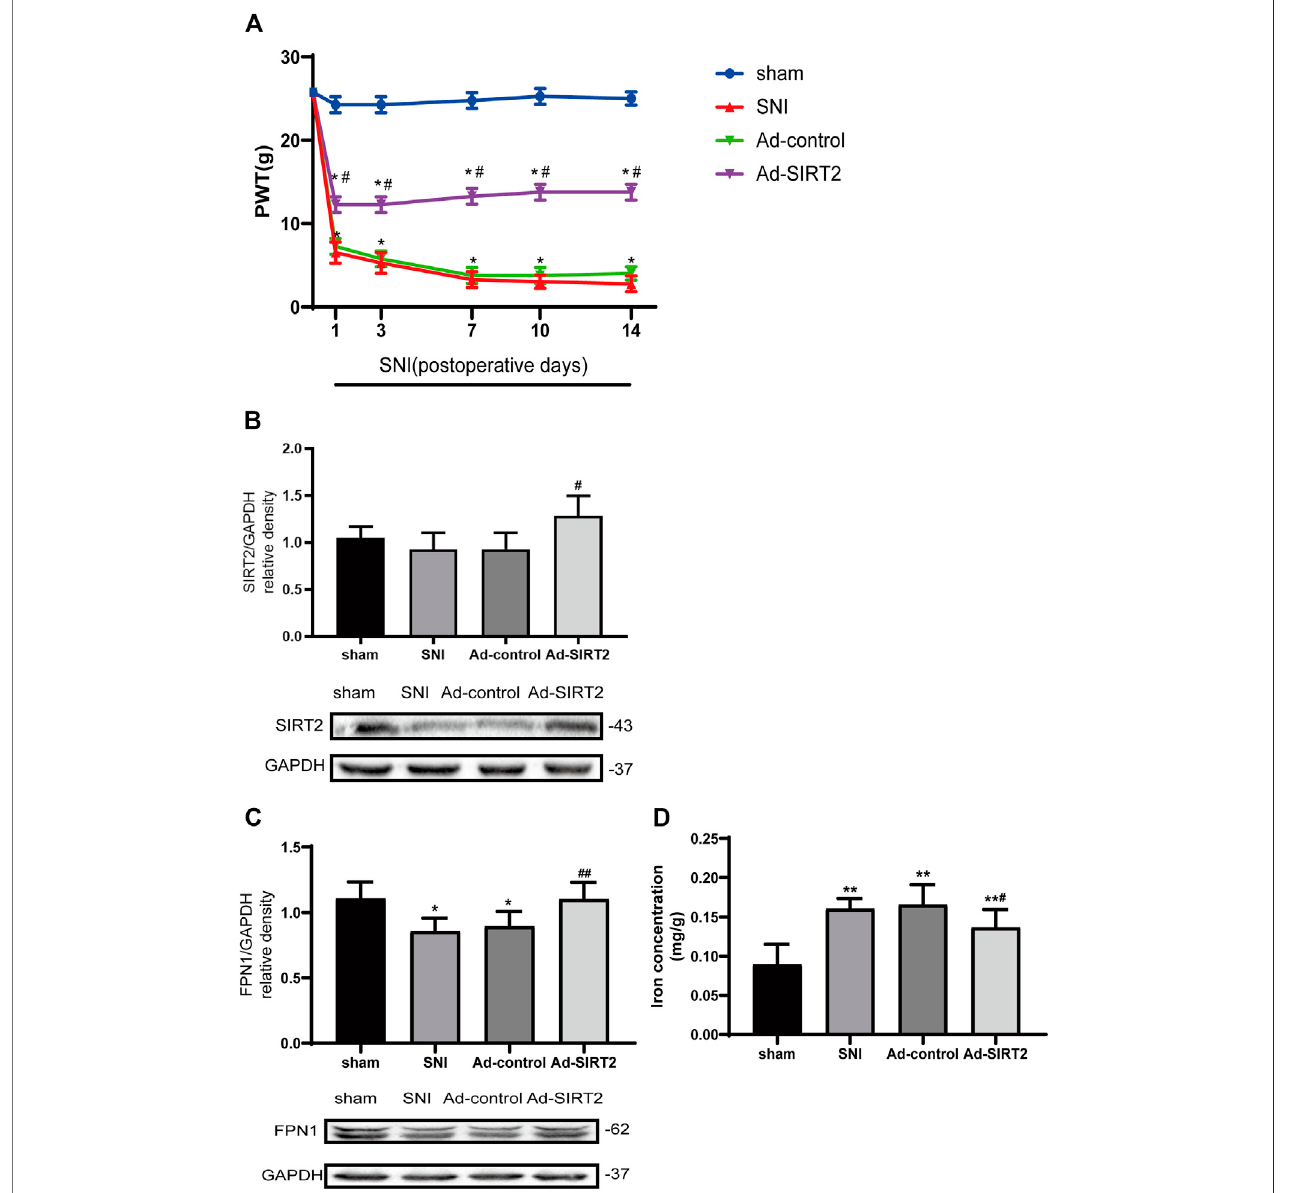
FIGURE 4 | Intrathecal injection of SIRT2 adenovirus attenuated mechanical allodynia in SNI rats, enhanced the expression of FPN1, and reduced iron accumulation induced by SNI. (A) The effects of the intrathecal injection of Ad-SIRT2 or Ad-control on PWT in the sham group or SNI group. (B) Changes to SIRT2 expression in the spinal cord after an intrathecal injection of Ad-SIRT2 or Ad-control. (C) Changes to FPN1 expression in the spinal cord after an intrathecal injection of Ad-SIRT2 or Ad-control. The rats in the sham operation group were used as controls. (D) Changes to iron concentration in the spinal cord after an intrathecal injectionofAd-SIRT2orAd-control.Valuesareexpressedasthemean±SE( n =5pergroup).* p -valuesof < 0.05and** p -valuesof < 0.01forcomparisonswithshamrats orbaselinevaluesoftheSNIrats(day0);# p -valuesof < 0.05and## p -valuesof < 0.01forcomparisonswithSNIorAd-controlrats.SNI,sparednerveinjury;SIRT2,sirtuin 2; FPN1, ferroportin